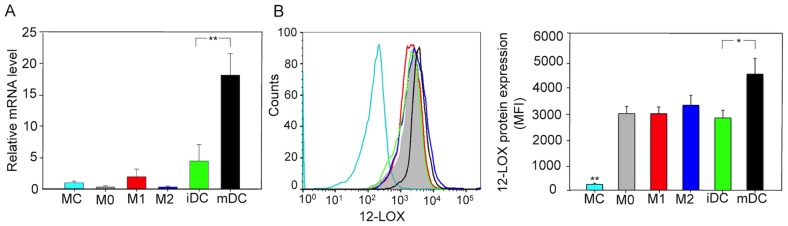
Human macrophages and dendritic cells express human 12-LOX.(A) Expression levels of 12-LOX mRNA in human monocytes (MC), M0, M1, M2 macrophages, immature dendritic cells (iDC) and mature dendritic cells (mDC) were assessed by quantitative PCR. (B) 12-LOX protein expression levels were assessed by flow cytometry. In the left panel, a representative histogram shows 12-LOX present in each cell type. In the right panel, results are mean fluorescent intensity (MFI) of 12-LOX protein levels for each cell type, expressed as mean±SEM of 4 separate cell preparations (*P<0.05, **P<0.01).